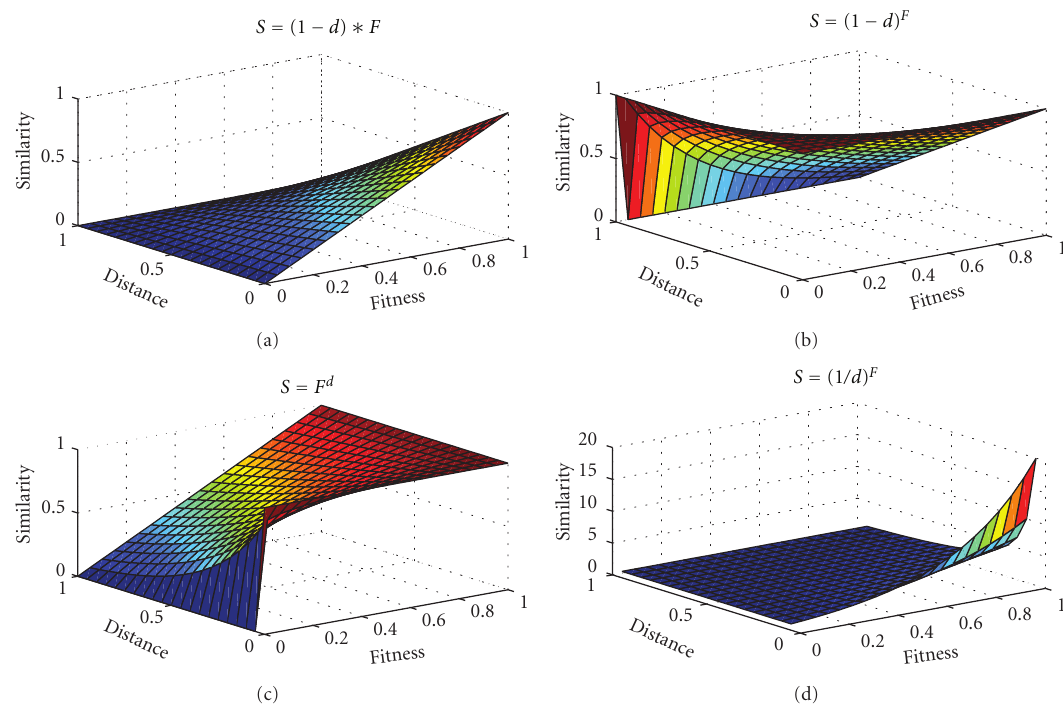
Figure 4: Similarity space— the similarity spaces of the four approaches of combining distance and fitness are shown. The goal is to achieve a high similarity when distance is small and fitness is high. Currently, the engine implements S = (1 − d ) ∗ F.